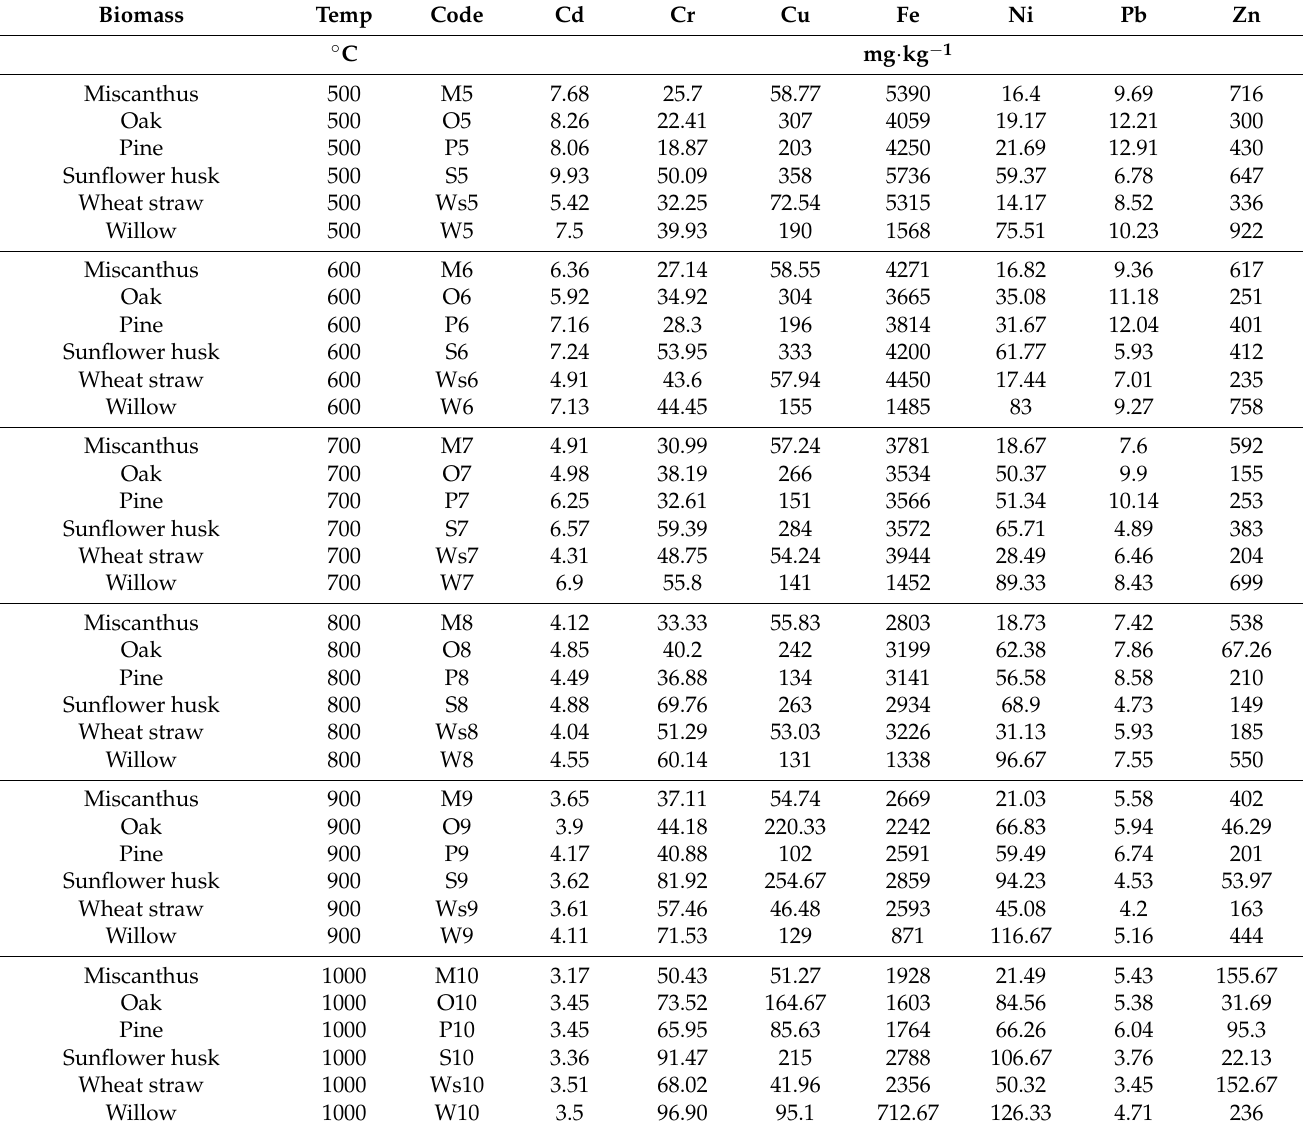
Table 2. Average contents of the studied heavy metals with distinction of biomass types and ashing